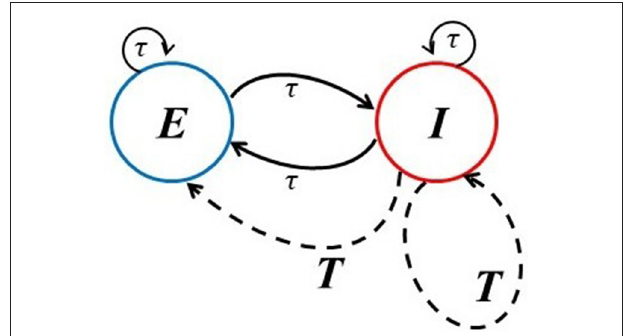
FIGURE 1 | Network architectures. The solid lines provide the schematic of the basic excitatory-inhibitory (EI) network in which the connections can have multiple smaller delays (denoted here by τ ) characteristic of local circuitry. The dashed lines account for an extra global inhibitory feedback with longer delay T from population I to itself and to the E